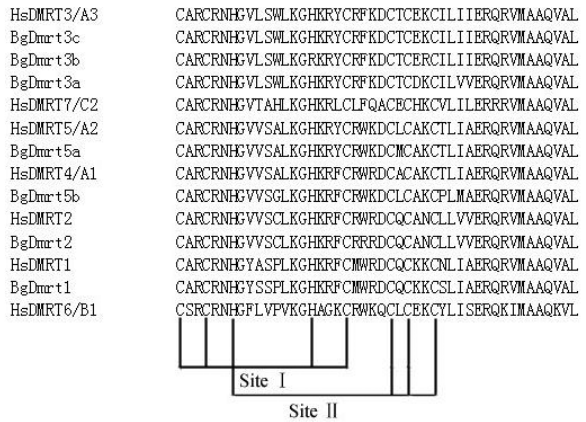
Figure 2 - Multiple alignment of the amino acid sequences of the dou- blesex/male abnormal 3 (dsx/mab-3 or DM) domains from toad ( Bufo gargarizans or Bg) and human ( Homo sapiens or Hs) DM related tran- scription factors (DMRTs). Two DM domain Zn-chelating sites, SiteI (CCHC) and siteII (HCCC), are also